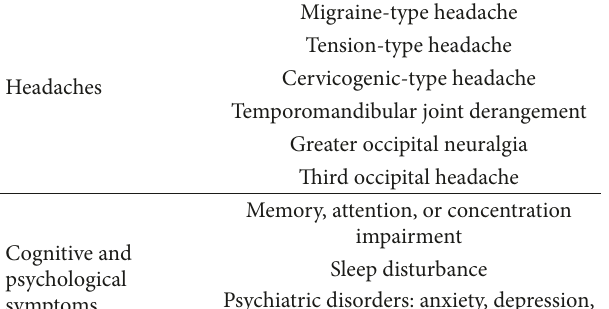
Table 1: Neurological symptoms after whiplash injury [1]. Table 2: Clinical classification on whiplash-associated disorders proposed by the Quebec Task Force